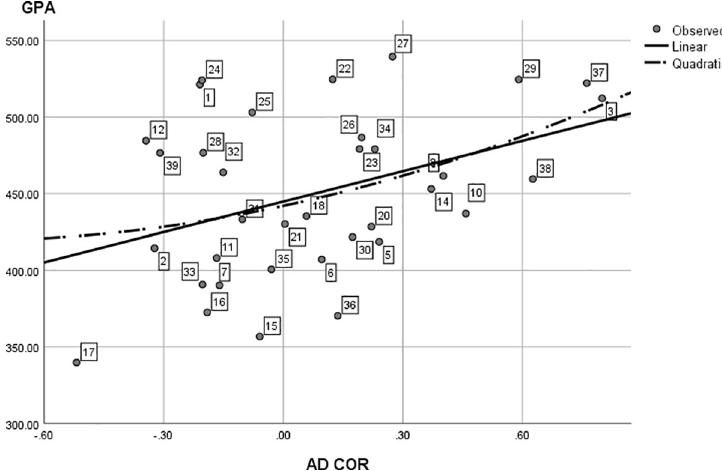
Fig 7. Post hoc analysis: The (Curvi-) linear regression of average study program results (GPA) on study program interest diversity. The data points (study programs) are labeled analogous to Table 1 and are identical to Fig 4, with omission of points 4, 9, 13 and 19 that were discussed